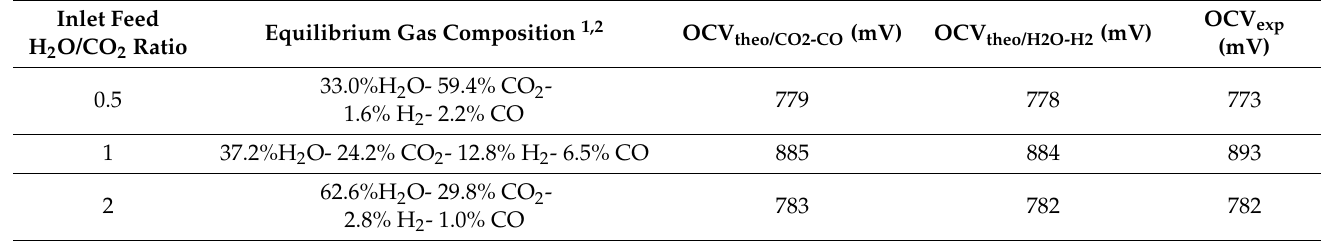
Table 1. Inlet feed composition and thermodynamic equilibrium gas composition for each saturated feed mixture studied and OCV calculated using the equilibrium compositions applied for p(CO 2 -CO) and p(H 2 O-H 2 ), at 900 ◦